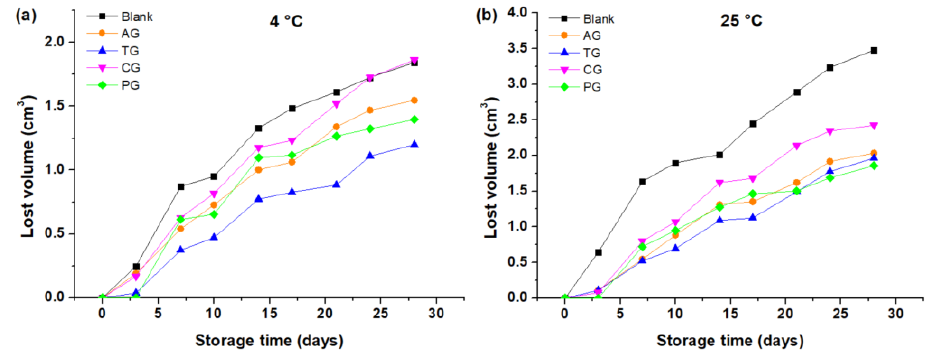
Figure 5. Lost volume as a function of storage time: ( a ) Creams stored at 4 ◦ C; ( b ) Creams stored at 25 ◦ C.